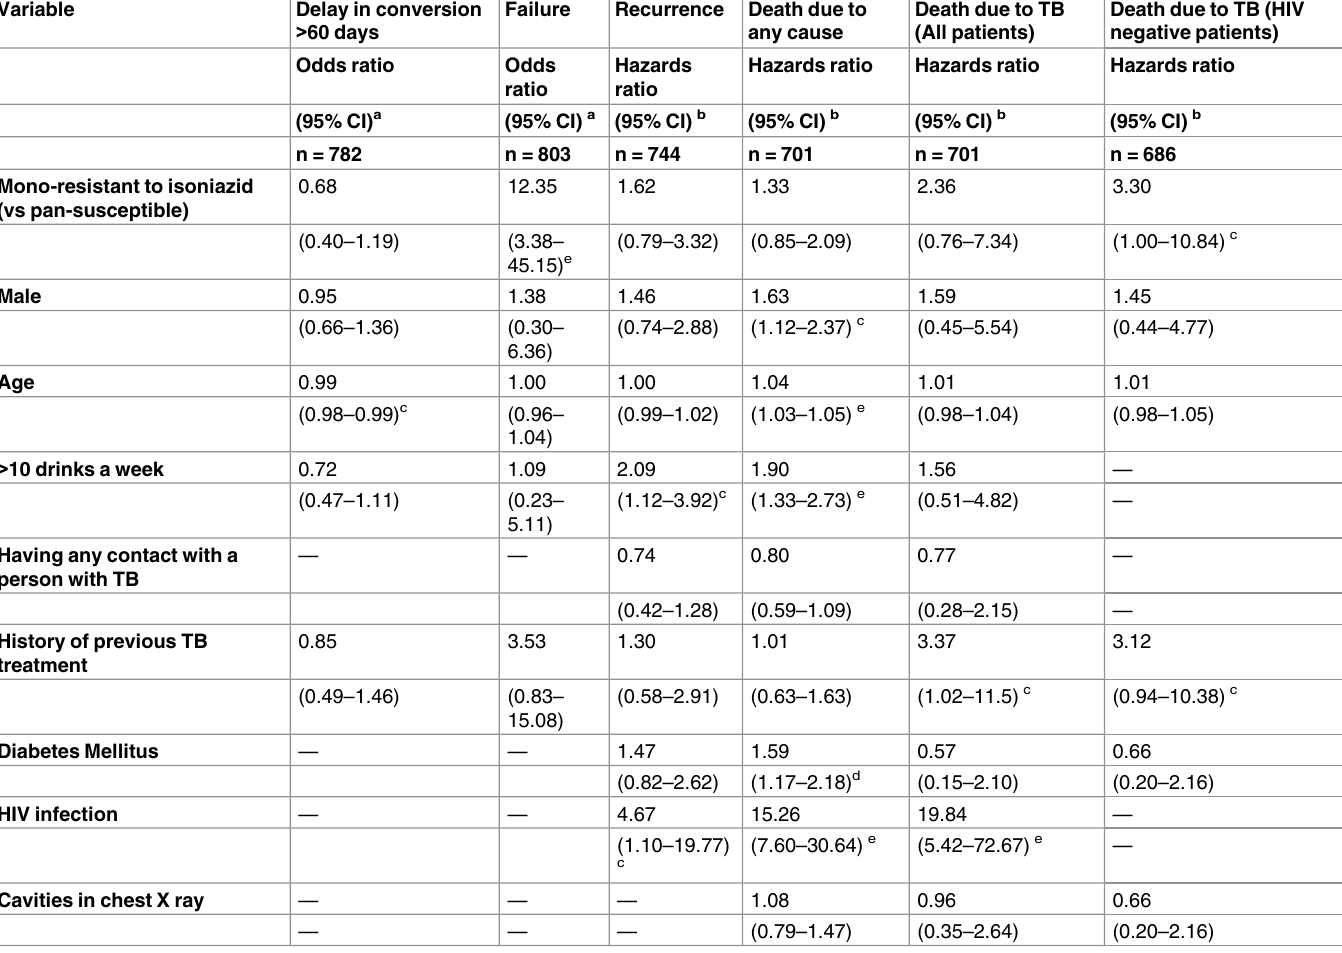
Table 5. Association of Drug Susceptibility and Selected Clinical Manifestations with Treatment Outcomes Among Patients with Pulmonary TB by Multivariate Analyses.